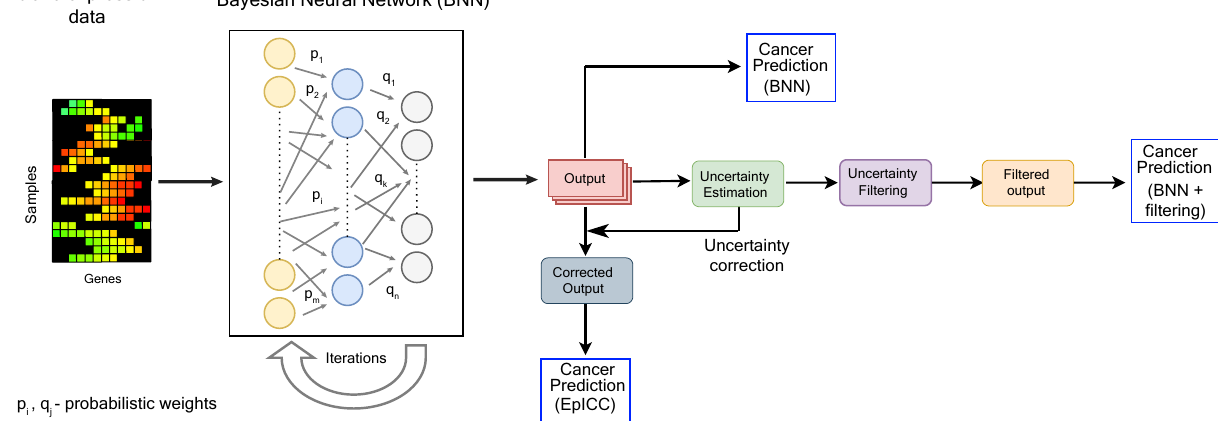
Figure 1. EpICC combines Bayesian Neural Network (BNN) with uncertainty correction. BNN utilizes the gene expression data of feature genes for cancer classification. The BNN consists of 3 layers with the first layer consisting 250 neurons, the second layer containing 95 neurons and the final layer consists of output neurons. The number of output neurons is dependent on the number of classes to be predicted. The weights of the connections were initialized from prior probability distributions. We refined the weights over multiple iterations through the BNN. The output was used for uncertainty estimation. After estimating the uncertainty, we tested two different approaches for incorporating uncertainty to improve classification accuracy—uncertainty filtering and uncertainty correction. We thus obtained the filtered and the corrected outputs respectively which we used for cancer type and subtype